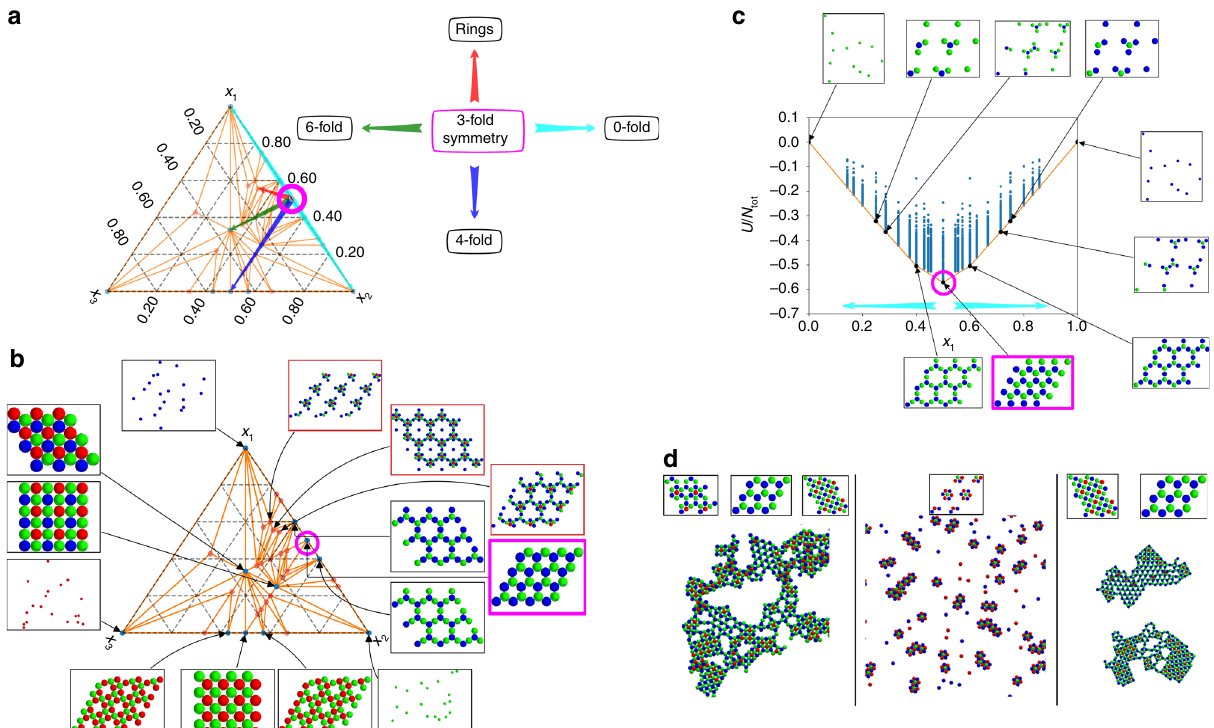
Fig. 6 Ternary phase diagram for an example multi- fl avored system. To a binary mixture where ( λ 1,1 = − 1.0, λ 1,2 = 0.5, λ 2,2 = − 1.0) a third component is added such that ( λ 3,1 = 0, λ 3,2 = 1, λ 3,3 = − 1). a The triangular phase diagram is shown with arrows indicating directions along which the rotational symmetry of the most stable lattice is changed, starting from the open honeycomb (3-fold rotational symmetry) lattice. For reference, this structure is everywhere indicated in magenta. b Detailed diagram of structures that belong to the convex hull of (free) energy. Only landmark structures are depicted, in addition to certain very low density (ring-like) structures of interest which are outlined in red. More detail is available in the Supplementary Discussion. c The binary phase diagram for the initial mixture to which the third component was added. The cyan arrows correspond to those in a . d Molecular dynamics snapshots for various systems taken at T * ≈ 0.02. From left to right, the stoichiometries, ( x 1 , x 2 , x 3 ), are as follows: (0.40, 0.47, 0.13), (0.4285, 0.1430, 0.4285), (0.4165, 0.5000, 0.0835). The predicted structures from the phase diagram are shown above the